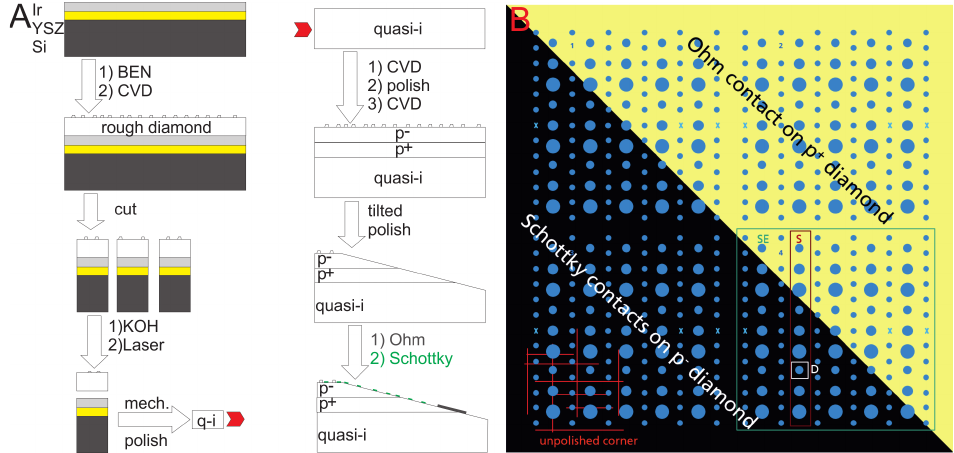
Figure 1. ( A ): Illustration of the growth process: Dia/Ir/YSZ/Si(001) was grown by BEN and CVD; the resulting substrate was cut into square-shaped pieces and the diamond was separated from the rest of the material. After mechanical polishing, the resulting quasi-intrinsic substrate was overgrown with a p + layer, polished again and overgrown again with a p − layer. A tilted mechanical polish allows for access to all layers. The ohmic contact was deposited on the p + region, whereas the smaller contacts for Schottky diodes were distributed over the whole substrate. ( B ): Schematic representation of a finished sample. For the characterizations in the further sections, the diodes were indexed by large sectors (SE), small sectors (S) and diode indices (D) within the sectors. The Ohmic contact extends over almost the entire p +